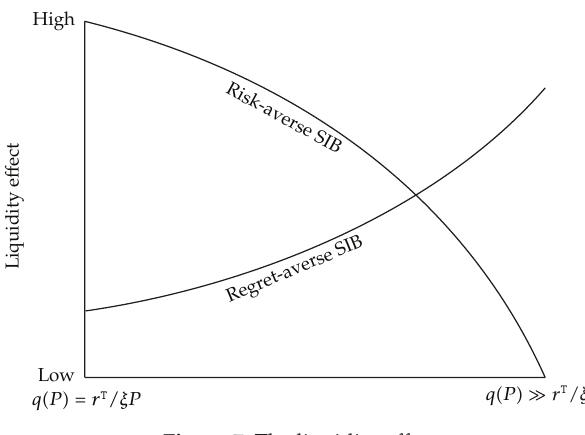
Figure 7: The liquidity e ff